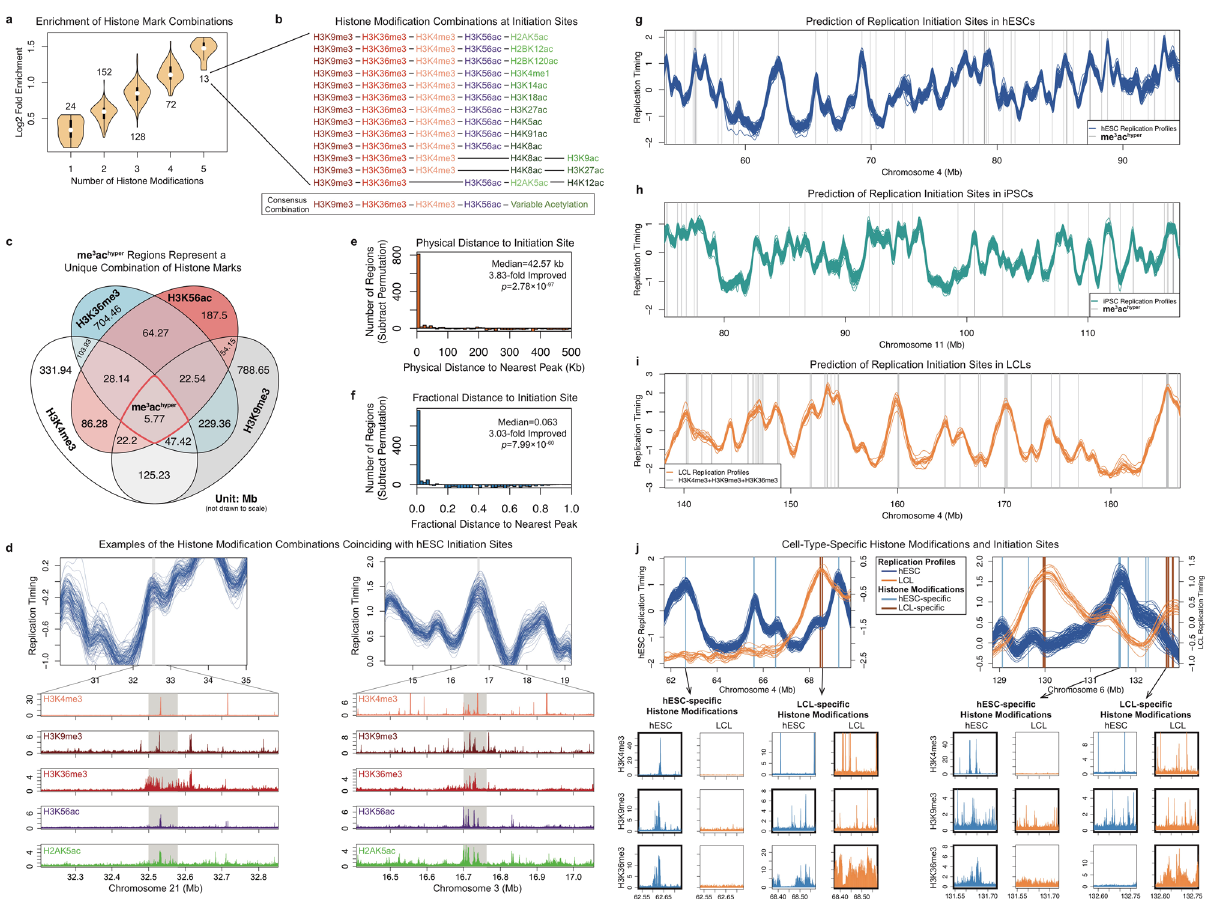
Fig. 3 Histone Modi fi cations Associated with Replication Initiation. a Iterative identi fi cation of histone mark combinations enriched at rtQTLs. Shown are enrichment distributions; the number of combinations in each category is indicated. Fold-enrichment increases gradually and is maximal for fi ve-mark combinations. n indicated in the plot, unit: histone mark combinations. b Histone modi fi cation combinations for human replication initiation. The 13 combinations of fi ve histone marks converged to a consensus combination. See Supplementary Table 1 for additional details. c The histone modi fi cations (independent of rtQTLs) represents a rare combination of both active and repressive histone marks. me 3 ac hyper regions comprised 0.7 – 3% of the regions that carry the individual histone marks. d Examples of histone mark combinations (Roadmap Epigenomics imputation) 72,73 coinciding with replication timing peaks not identi fi ed as rtQTLs. e , f Distribution (after subtraction of permutations) of physical ( e ) and fractional distances ( f ) of the me 3 ac hyper locations to the nearest replication timing peak. We also indicate the fold-improvement in median distance to the nearest peak compared with random expectation. See Supplementary Fig. 5c, d for further comparison with random. Panels e and f used a one-sided Wilcoxon rank-sum test. Correction for multiple testing was not applicable, as there was only one test for each sub-plot. g Combination of histone marks (gray, me 3 ac hyper locations) predict replication initiation sites in hESCs. h , i Histone modi fi cation locations (gray vertical lines) correspond to replication timing peaks in iPSCs ( h ) and LCLs (i). j Cell-type-speci fi c histone modi fi cation locations mark cell-type-speci fi c replication initiation sites. At regions with distinct replication timing pro fi les for hESCs and LCLs, LCL (hESC)-speci fi c replication timing peaks are predicted by LCL (hESC)-speci fi c histone modi fi cation locations. Lower panels: initiation sites coincide (thick borders) with all three histone trimethylation marks in the cell type in which they are active, but with one or none of the marks in the cell type in which they are